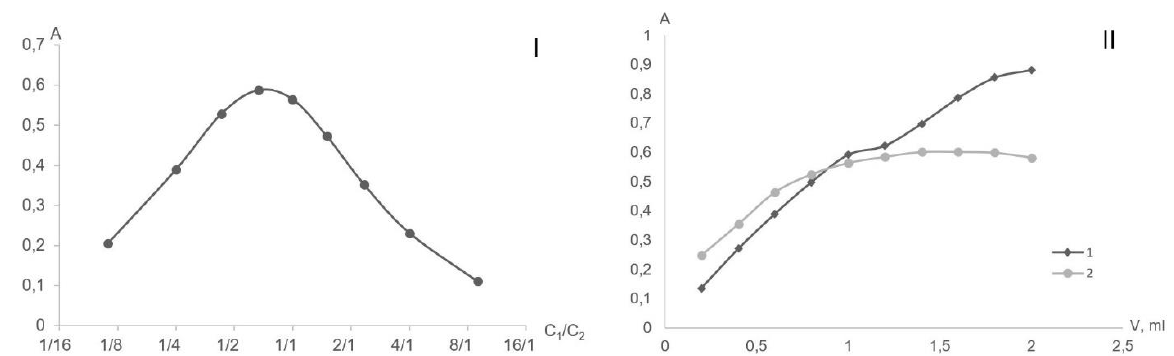
Fig. 3. I – Graph of the dependence of optical density on the composition of isomolar solution (C – 0.001 M diazole 1 red 2J solution, C – 0.001 M lamotrigine solution) at λ =370 nm; II – Saturation curves: 1 – lamotrigine at a constant 2 max concentration of diazole red 2J (1.00 ml of 0.001 M solution); 2 – diazole red 2J at a constant concentration of lamotrig- ine (1.00 ml of 0.001 M solution) at λ =370 max